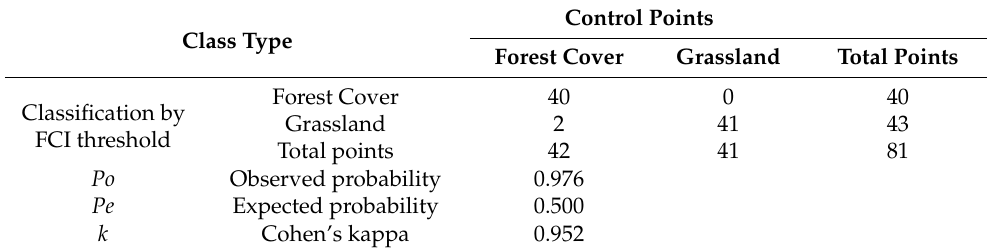
Table 5. Confusion matrix of “forest-grasslands” control points classification.